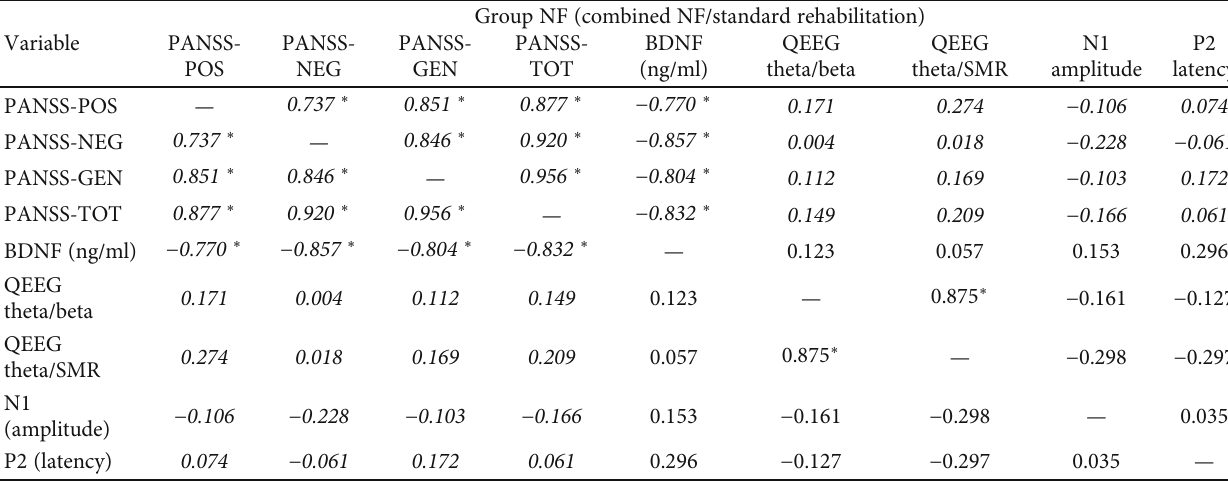
Table 4: Correlations between the magnitudes of changes from pretherapy to posttherapy measurements in the group of patients participating in a combined NF/standard rehabilitation program (group